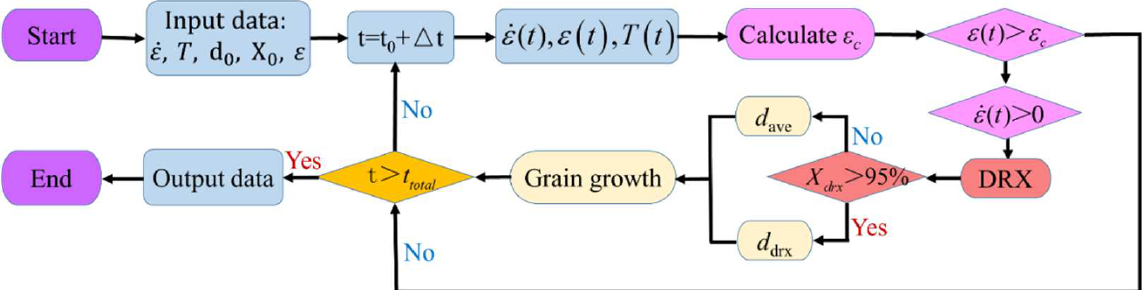
Figure 19. Flow chart to simulate the DRX behavior and grain size.